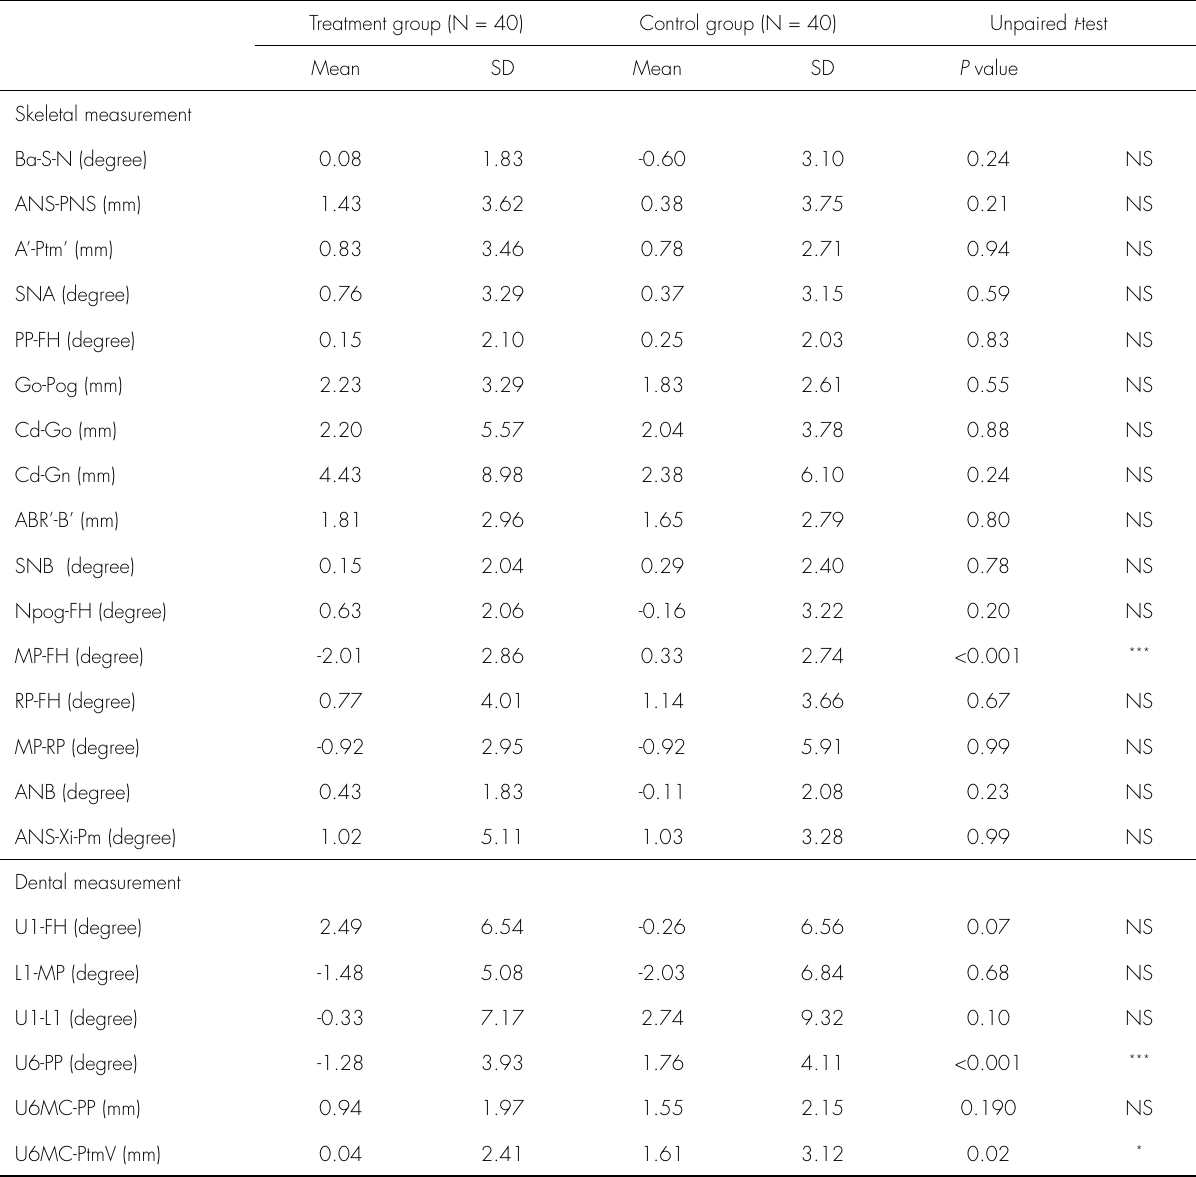
Table V. Results of treatment changes in cephalometric measurements for the treatment and control groups.